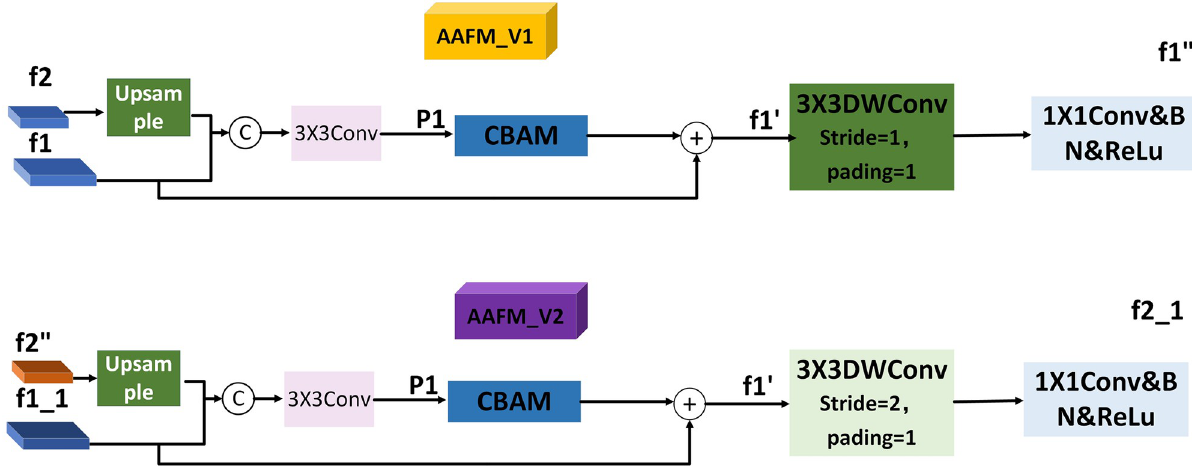
Fig 3. Attention aggregation feature module AAFM_V1, AAFM_V2.